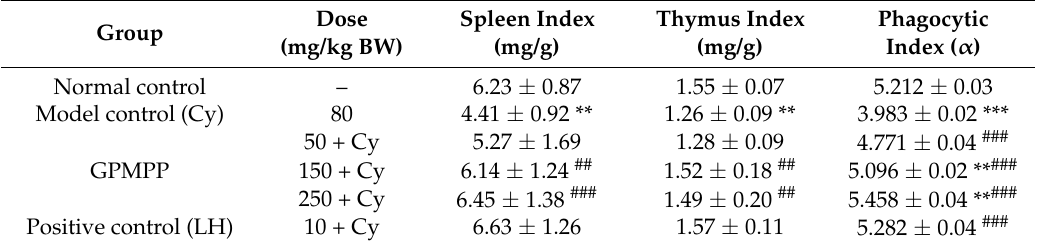
Table 1. Effects of GPMPP on spleen, thymus and phagocytic index of Cy-immunosuppressed